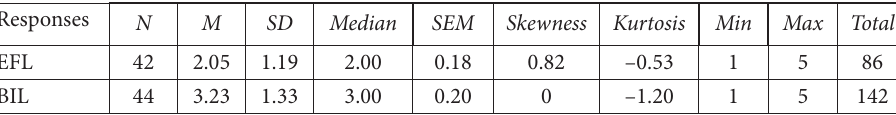
Table 6. Descriptive statistics of the scale items F – time, effort, and energy for English as foreign lan- guage (EFL) and bilingual (BIL) groups (source: created by authors) Responses